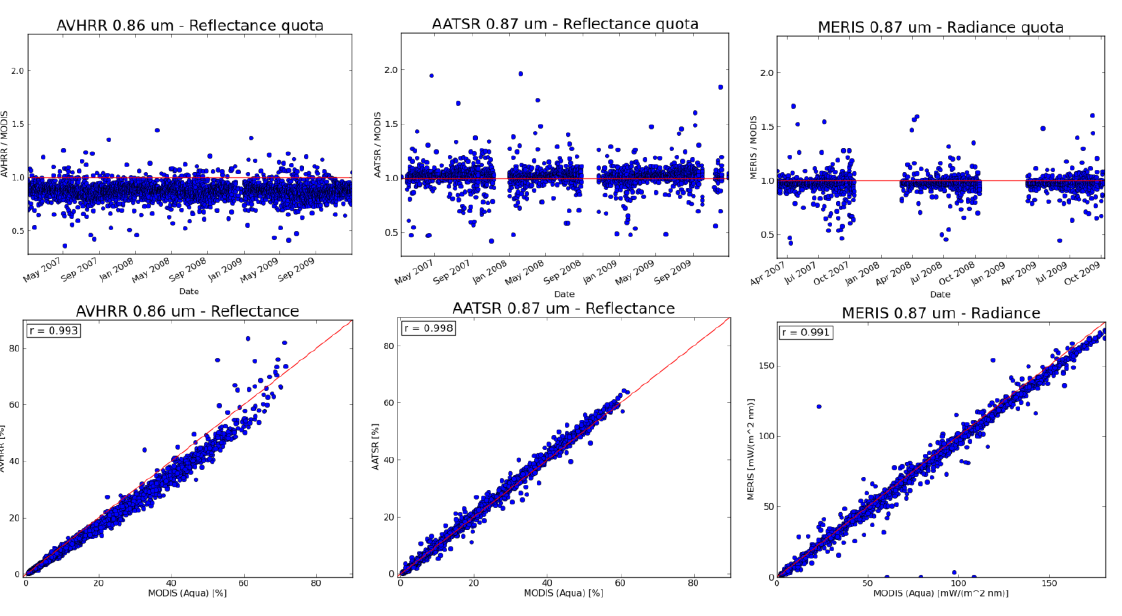
Figure 6. Inter-comparison of radiances against MODIS for the AVHRR-heritage channel at 0.9 µm for AVHRR ( Left ), AATSR ( Middle ), and MERIS ( Right ). Upper panels show results expressed as reflectance factor quotas or radiance quotas over the full time series and lower panels show results expressed as scatter plots.